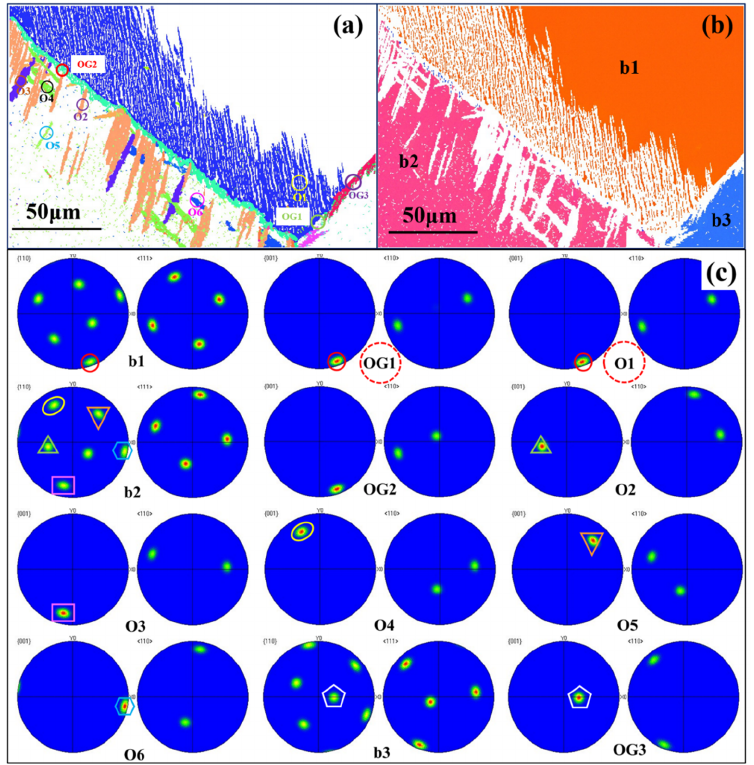
Figure 8. The inverse pole figures (IPF) maps ( a ) of O phase and ( b ) of B2 phase. ( c ) The {110},